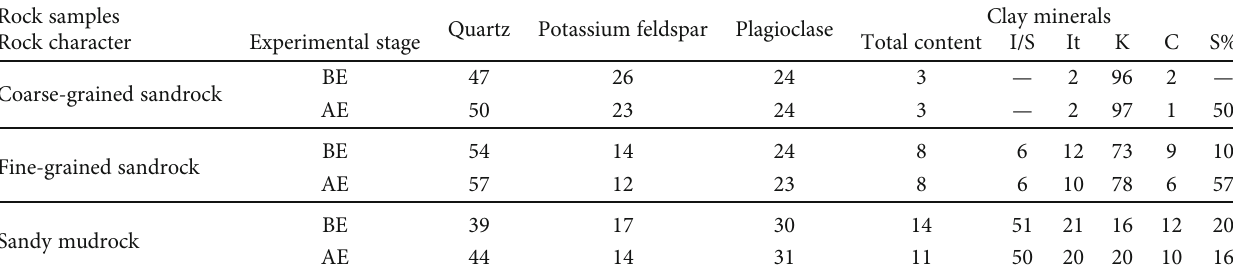
Table 1: Mineral compositions of specimen surfaces before and after the experiment (%).